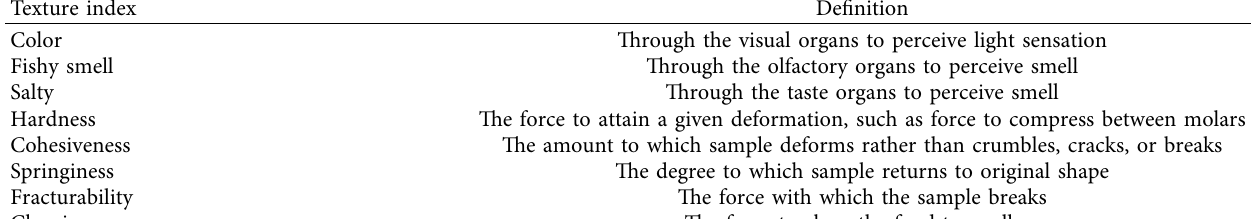
Table 1: Sensory description words and definitions of sea cucumber [17, 19].